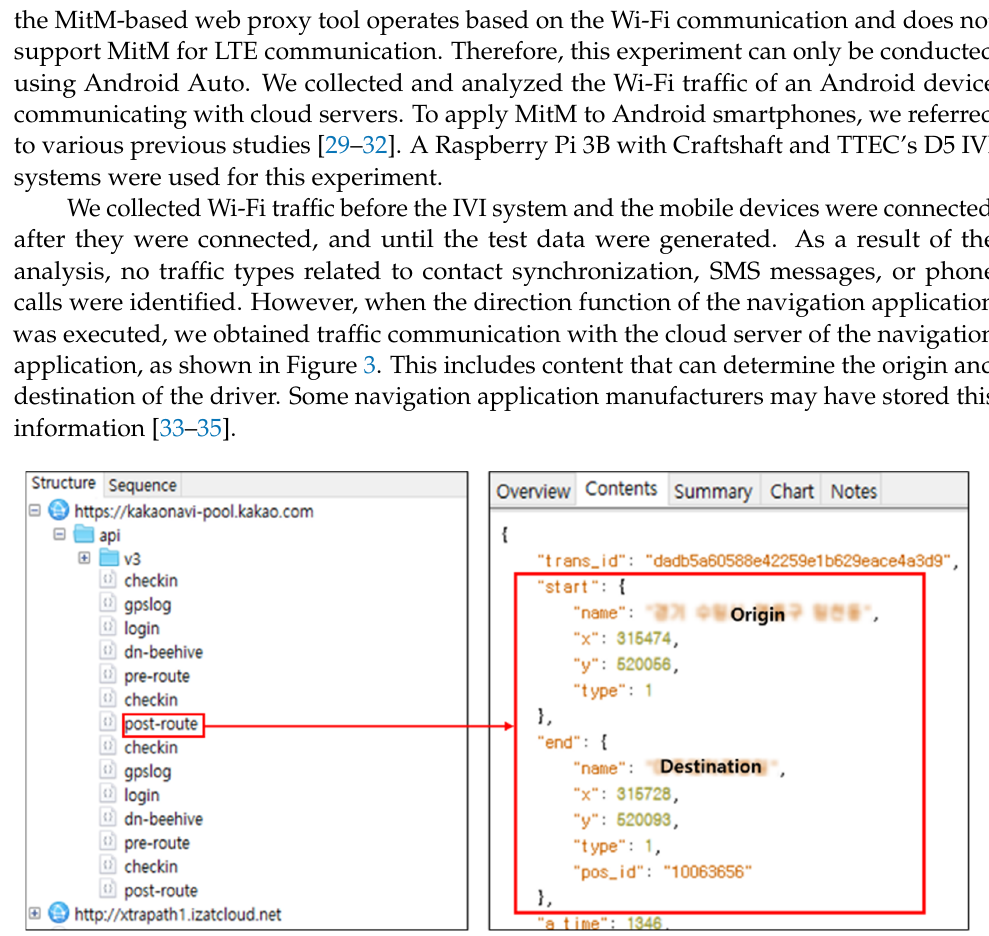
Figure 3. Communication traffic of navigation